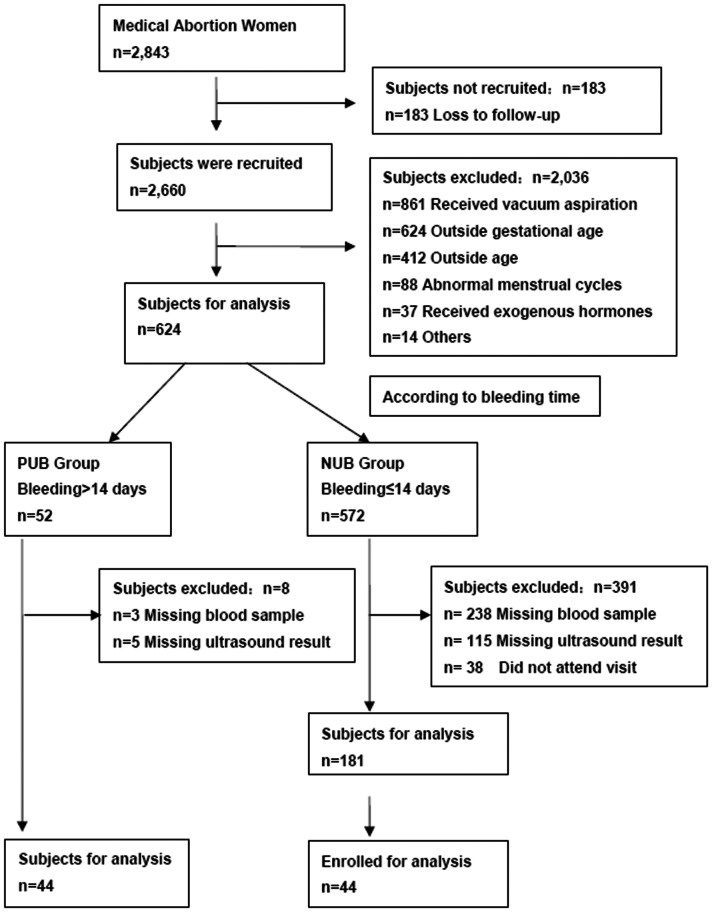
Flow diagram of subjects who underwent medical.